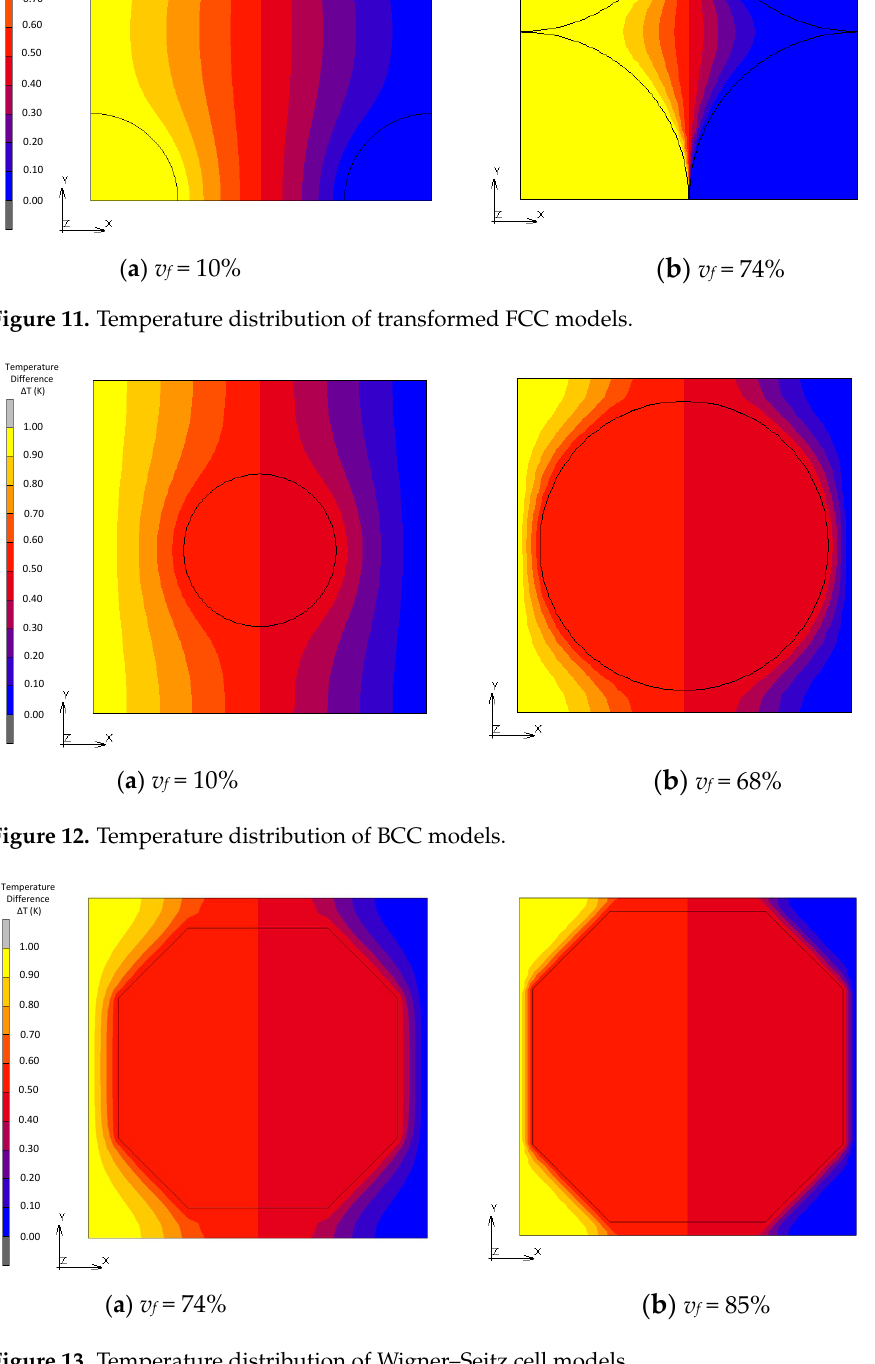
Figure 13. Temperature distribution of Wigner–Seitz cell models.